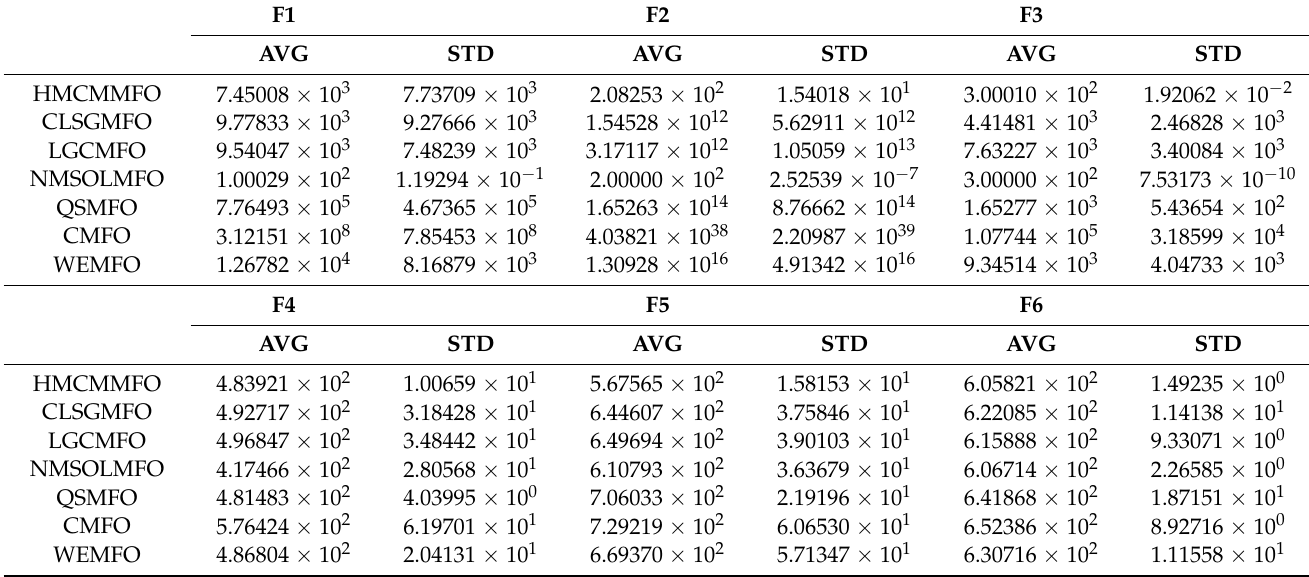
Table 6. Comparison of MFO-variant